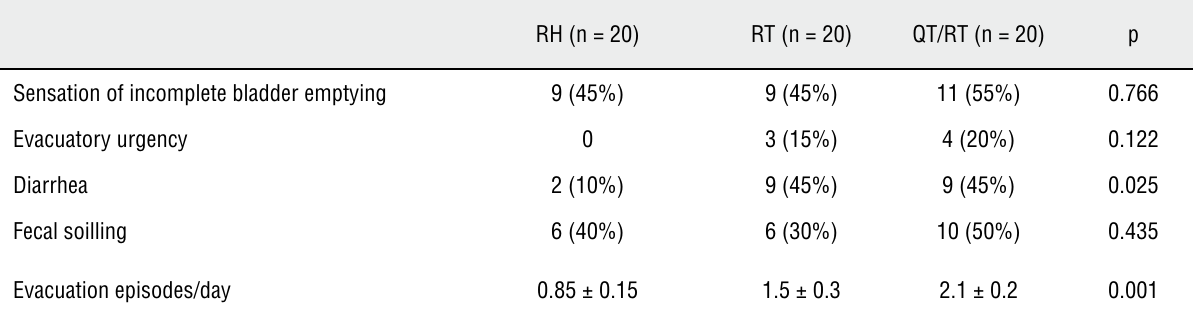
Table 3 - Intestinal symptoms according to treatment type.